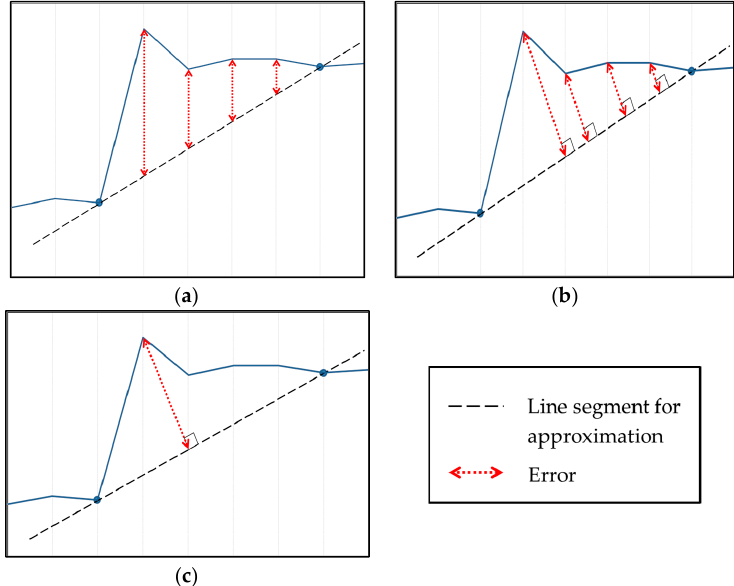
Figure 6. Three types of error function ( ErrorFnc ) for PLA. ( a ) RMSE; ( b ) Euclidean Error; ( c ) Euclidean Distance.